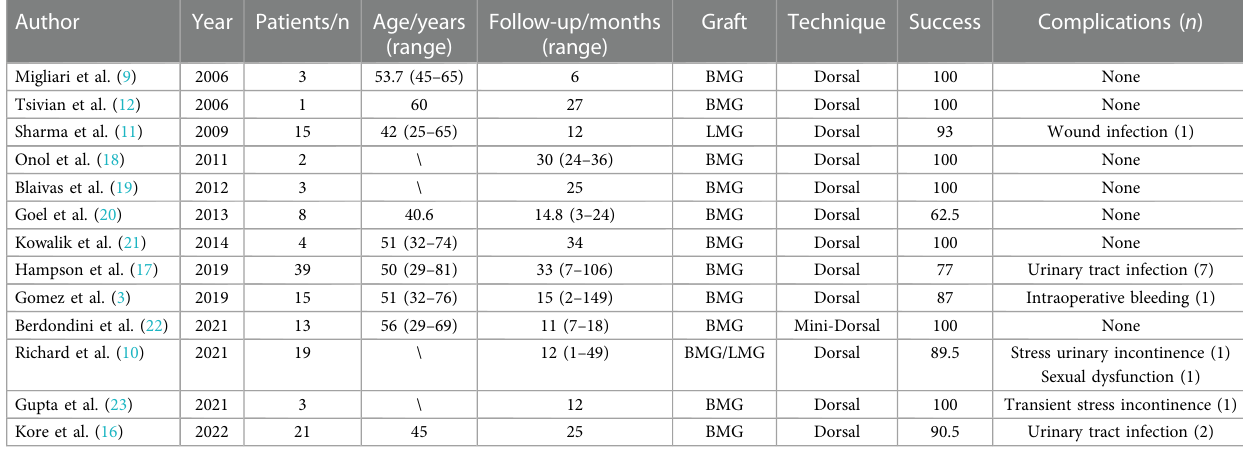
TABLE 1 Current literature of dorsal oral mucosa graft urethroplasty.